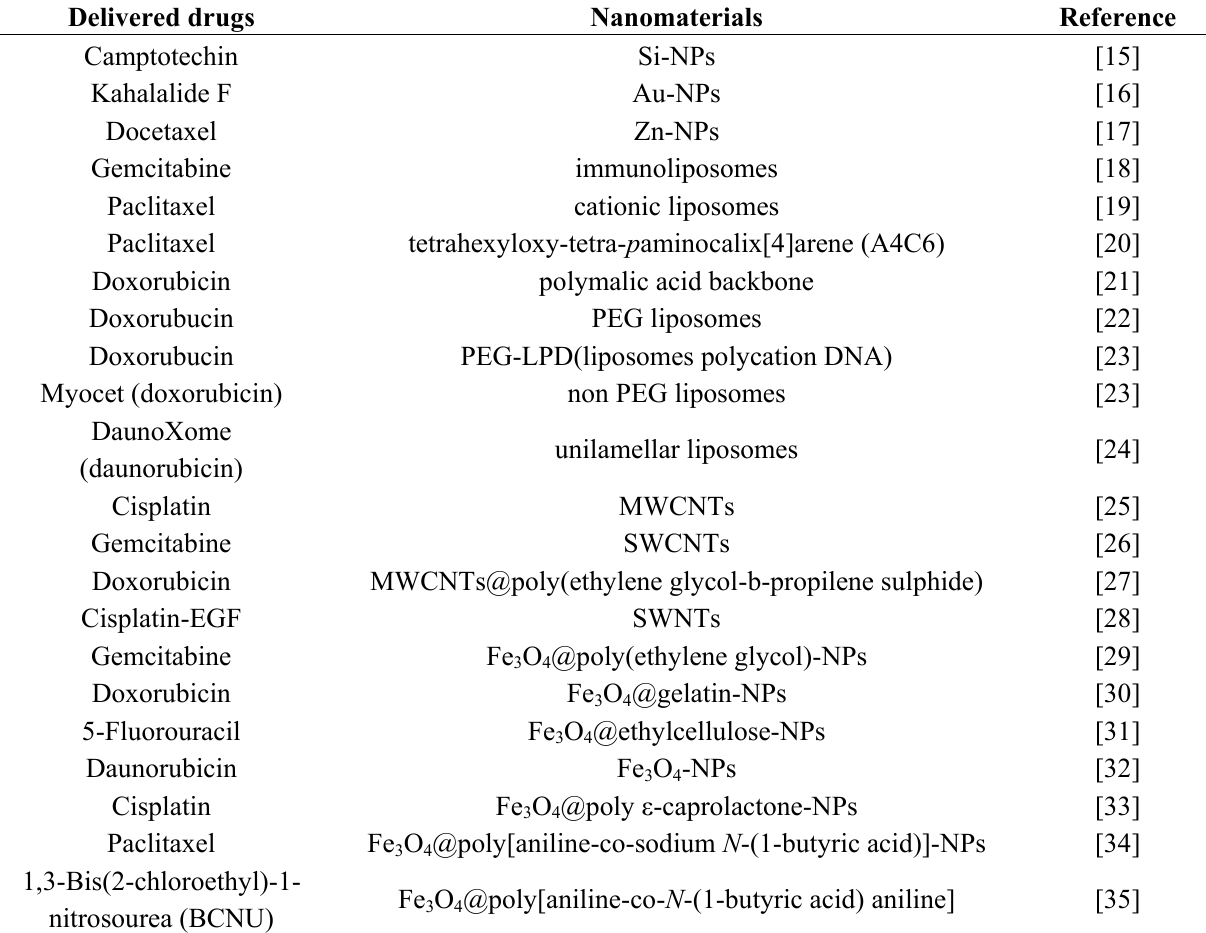
Table 1. Examples of nanoparticles delivered anti-cancer drugs. Delivered